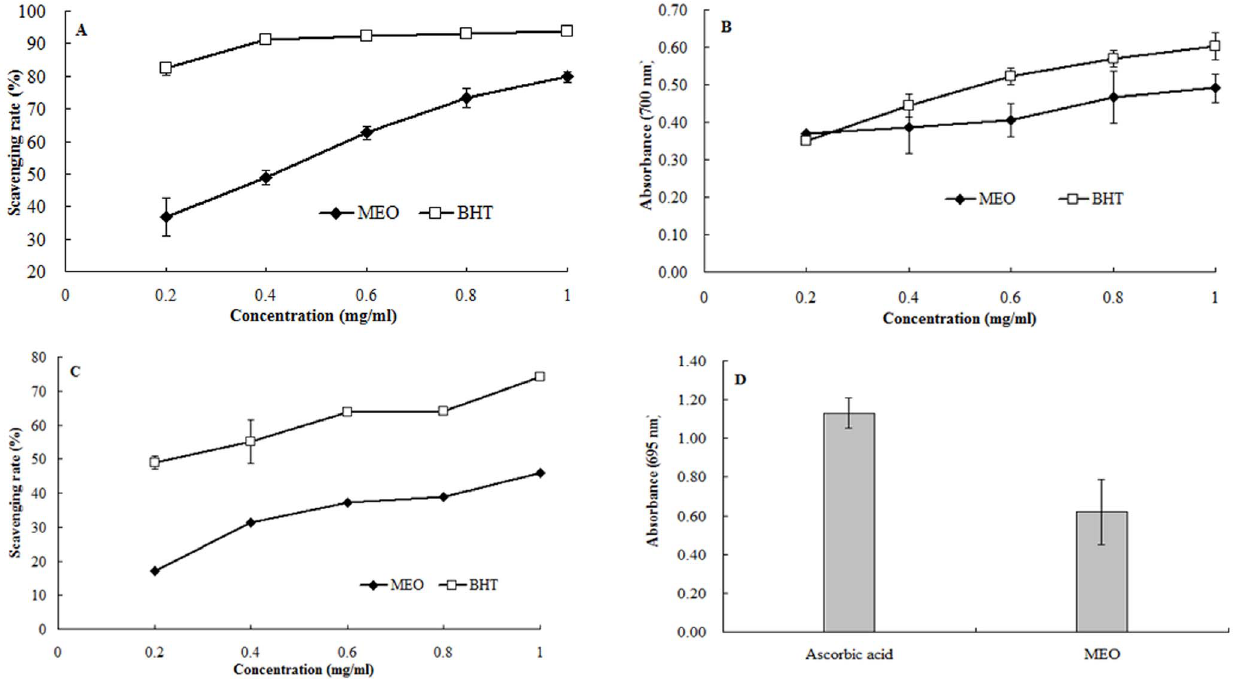
Fig. 4. Antioxidant activities of MEO, (A) scavenging of DPPH radical, (B) scavenging of hydroxyl radical, (C) reducing power and (D) total antioxidant activity. Values were representative of three separated